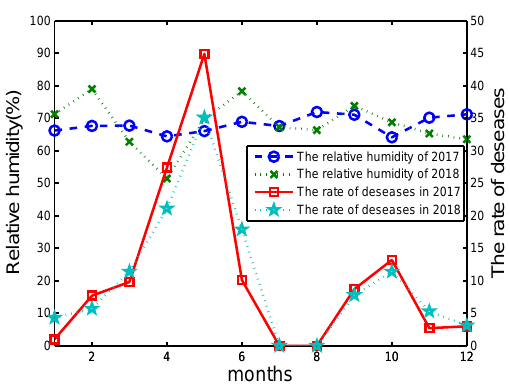
Figure 16. The relative humidity and wheat incidence in Yangtze River Zone of China from 2017 to 2018.